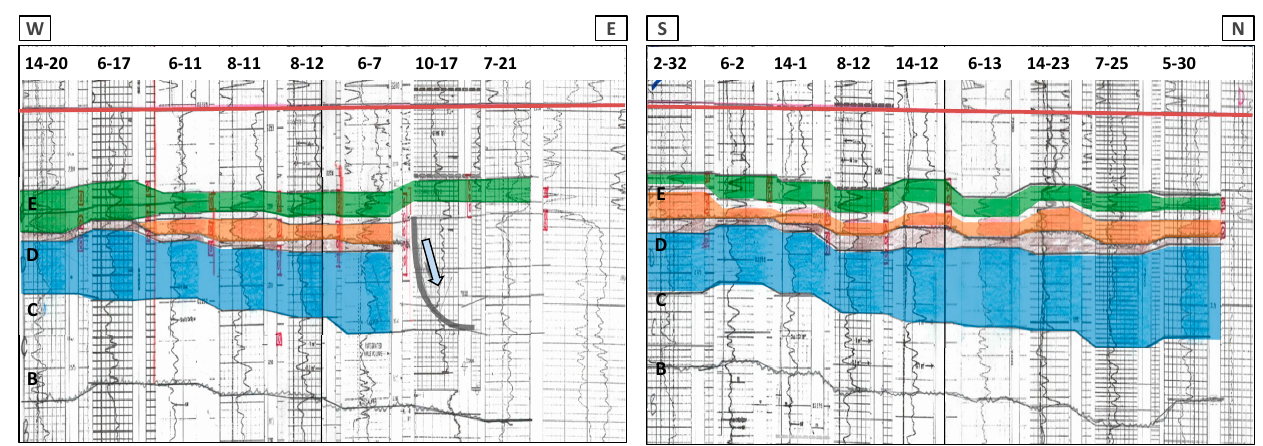
Figure 8. Viking cross section (N-S, E-W) in the study